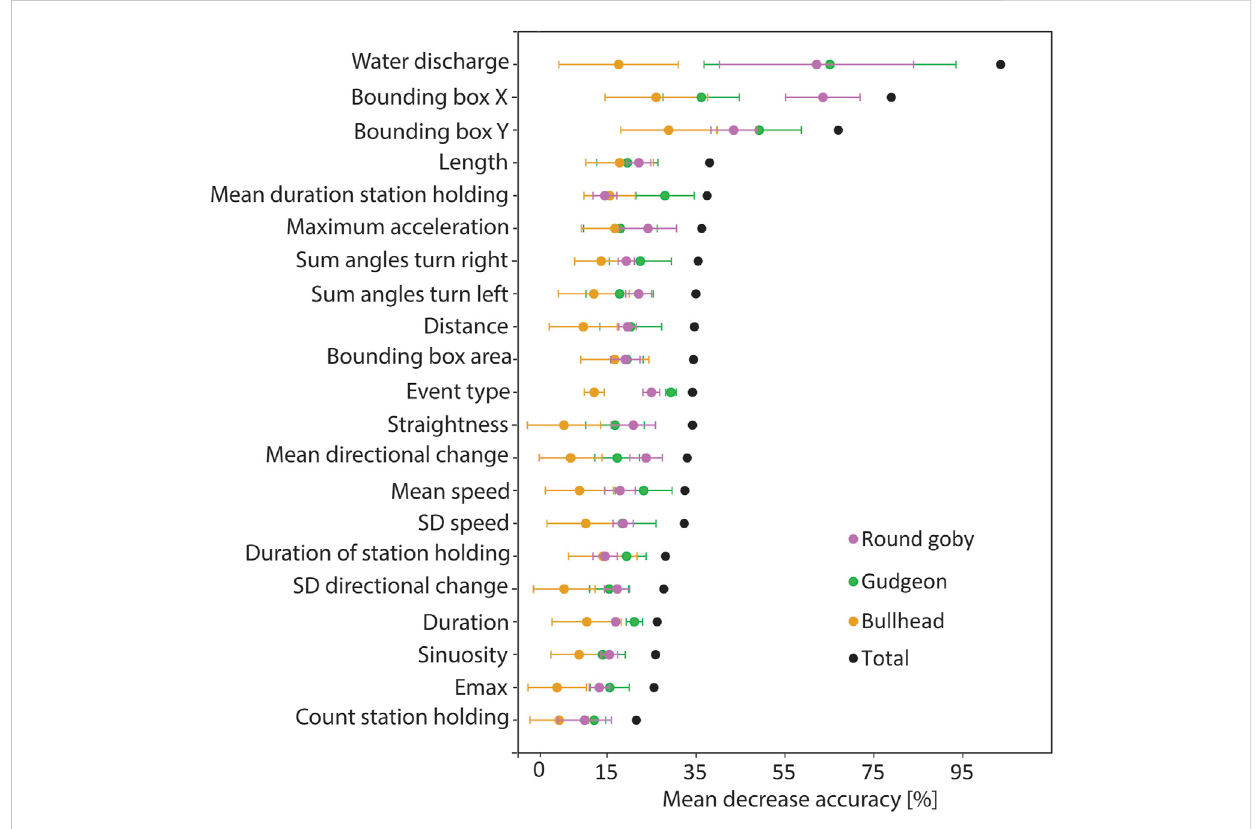
FIGURE 6 Prediction importance for the trajectory features (abszissa) measured as mean accuracy decrease when predicting without the corresponding feature (ordinate). Error bars indicate the standard deviation between the models of the cross